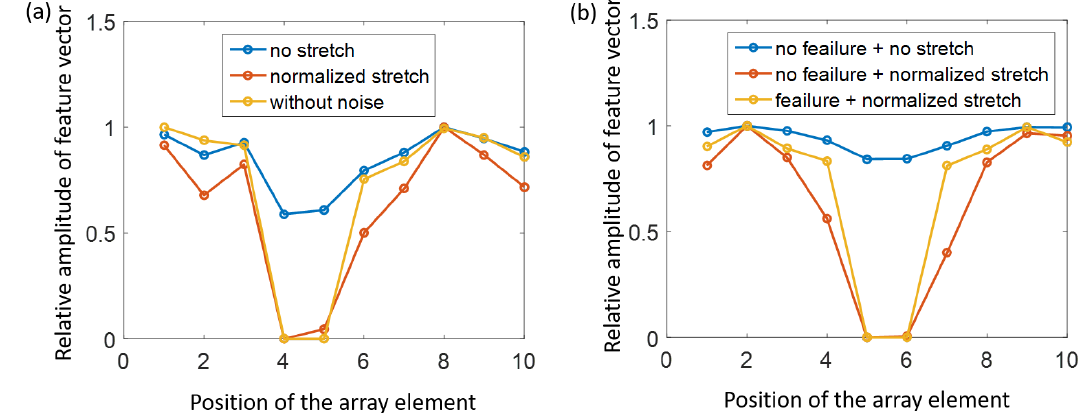
Figure 3. The feature vector with and without normalized stretching. The x-axis is corresponding to the location of each element in the sub-array, and the y-axis is the relative amplitude of feature vector. ( a ) The vector corresponding to a sub-array with the failed elements of No. 4 and No. 5. ( b ) The vector corresponding to a no-failure sub-array and a sub-array with the failed elements of No. 5 and No.